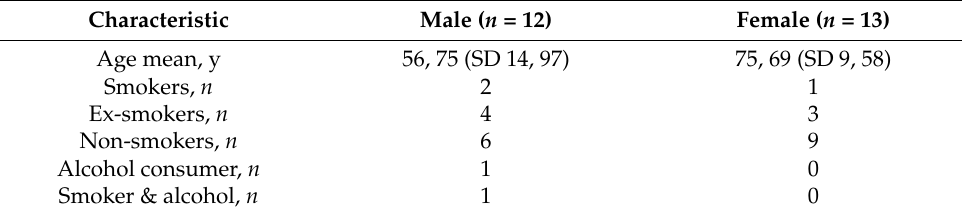
Table 1. Demographic information of patients examined ( n = 25).